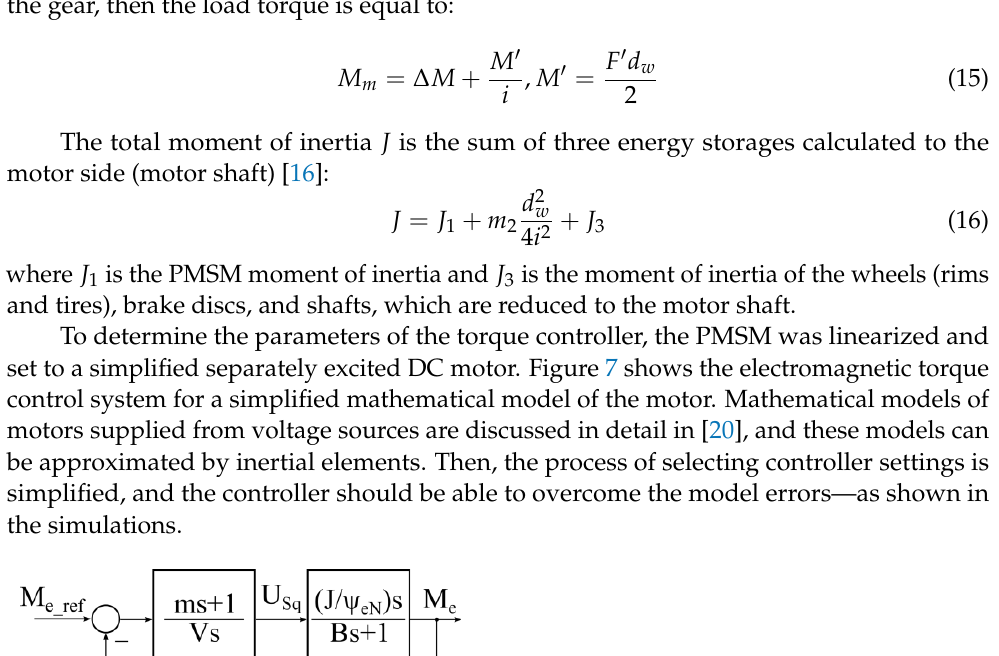
The new symbols in Figure 7 are the electromechanical time constant B and the flux ψ eN for the rated current i SdN in the d axis, where B = J R S